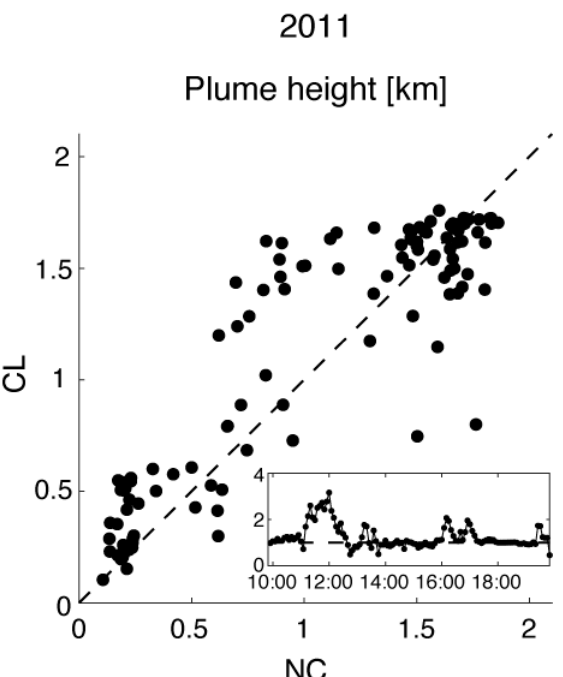
Figure 9. Scatter plot of five-minute mean plume height, defined as the height of the 15 µg m − 3 domain-maximum concentration contour, in the control (2011CL) and no-canopy (2011NC) simulations. Inset panel depicts time series of the ratio of plume heights in the two simulations (x-axis: time [EDT]; y-axis: 2011CL plume height divided by 2011NL plume height). The dashed line (at y = 1) shows where the 2011CL value equals the 2011NC value.